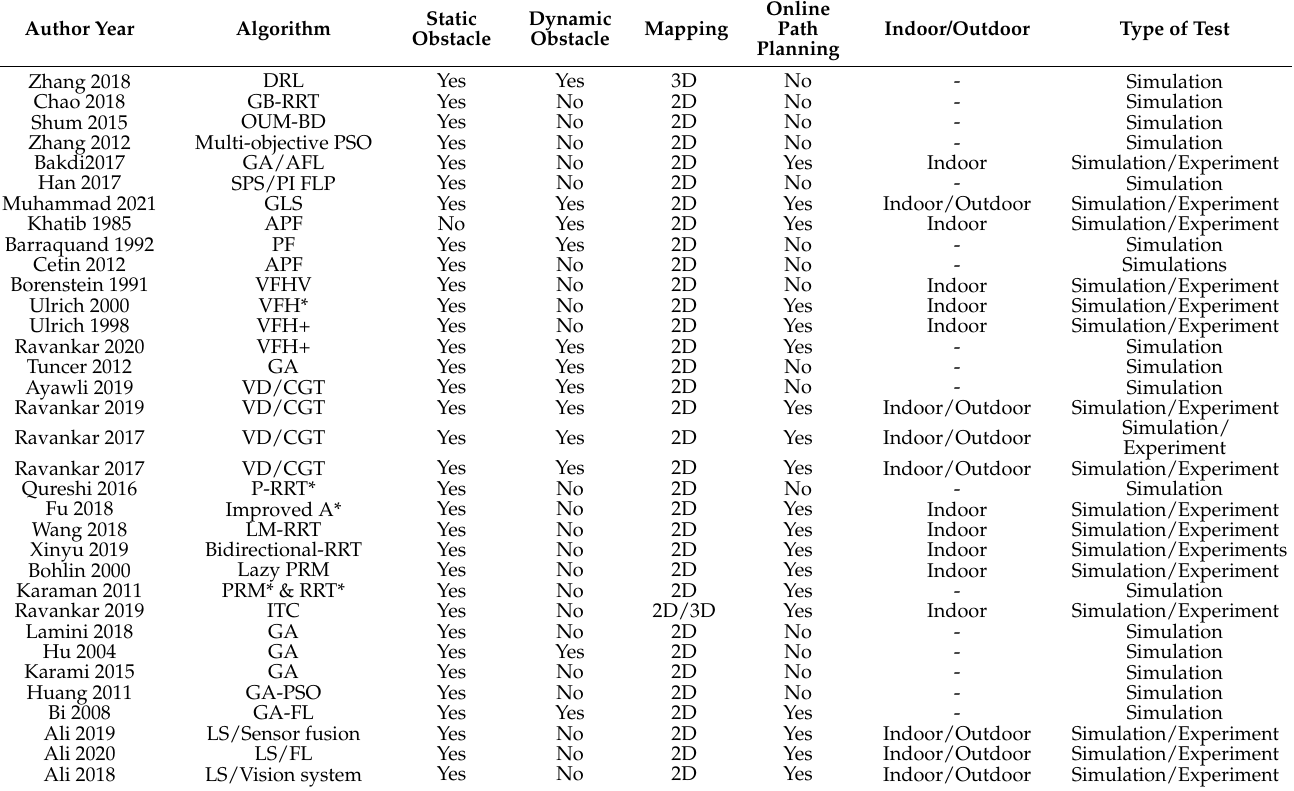
Table 1. Illustrates a comparison between reviewed